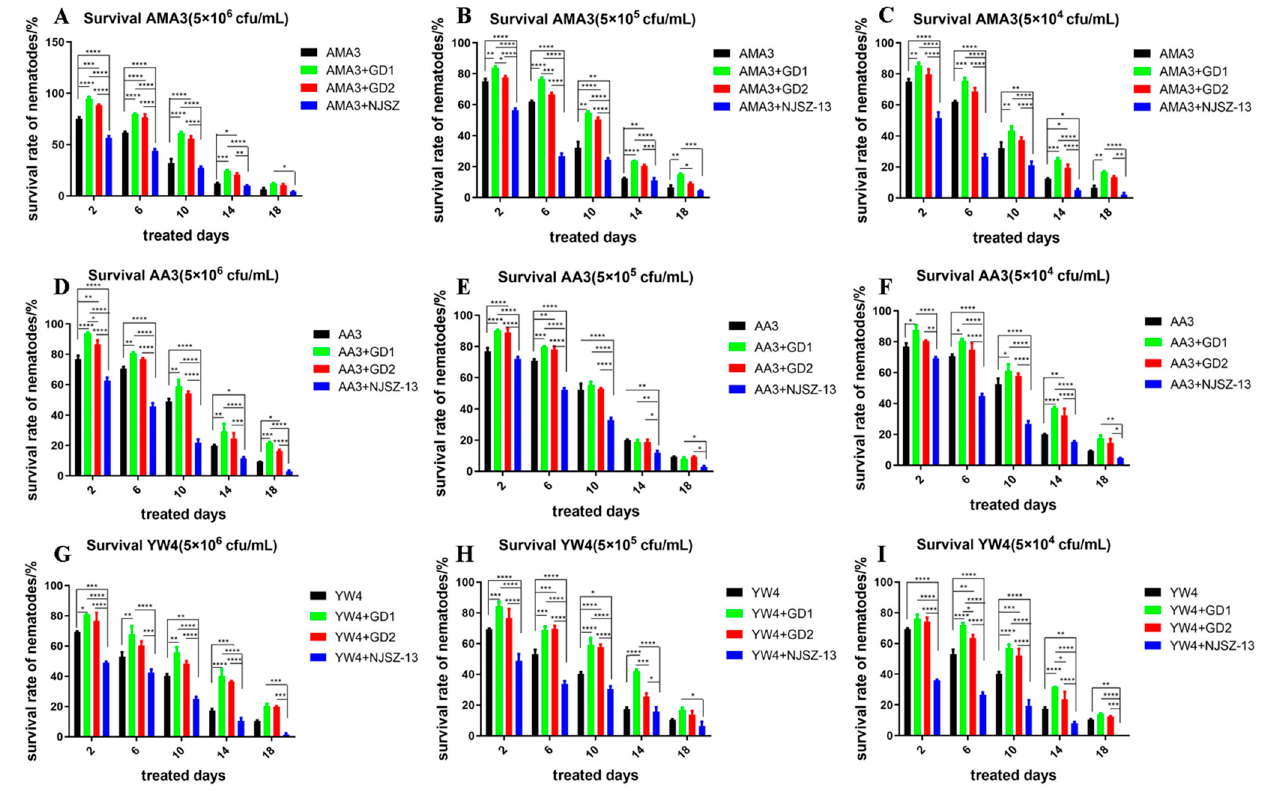
Figure 1. E ff ect trend of three di ff erent bacteria on the survival of di ff erent virulent pine wood nem- atodes (PWNs). ( A – C ) E ff ect trend of three strains of bacteria on AMA3 survival of PWNs. ( D – F ) nematodes (PWNs). ( A – C ) Effect trend of three strains of bacteria on AMA3 survival of E ff ect trend of three strains of bacteria on AA3 survival of PWNs. ( G – I ) E ff ect trend of three strains of bacteria on YW4 survival of PWNs. All data are presented as the means ± SEM. All of the results